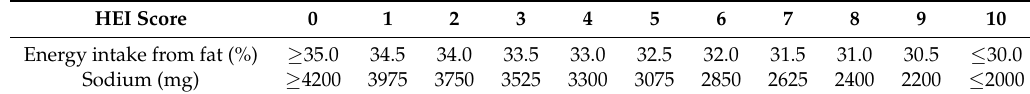
Table 2. Malaysian Healthy Eating Index (HEI) scoring for